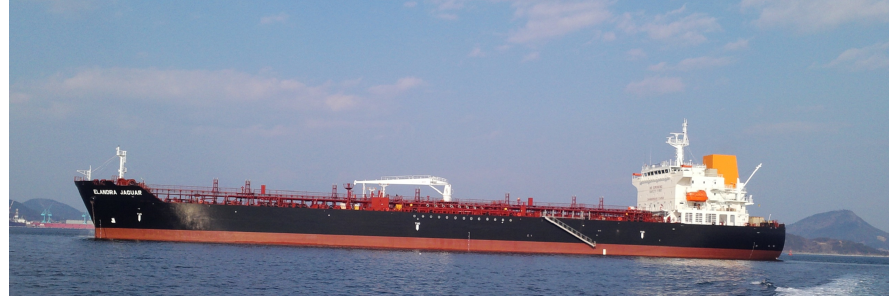
Figure 15. Target